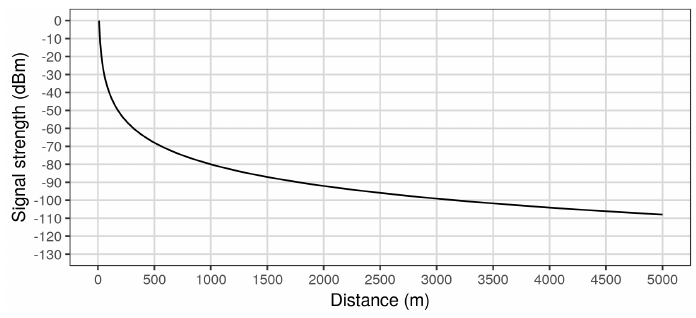
Figure 1: Signal strength as a function of the distance for a specific